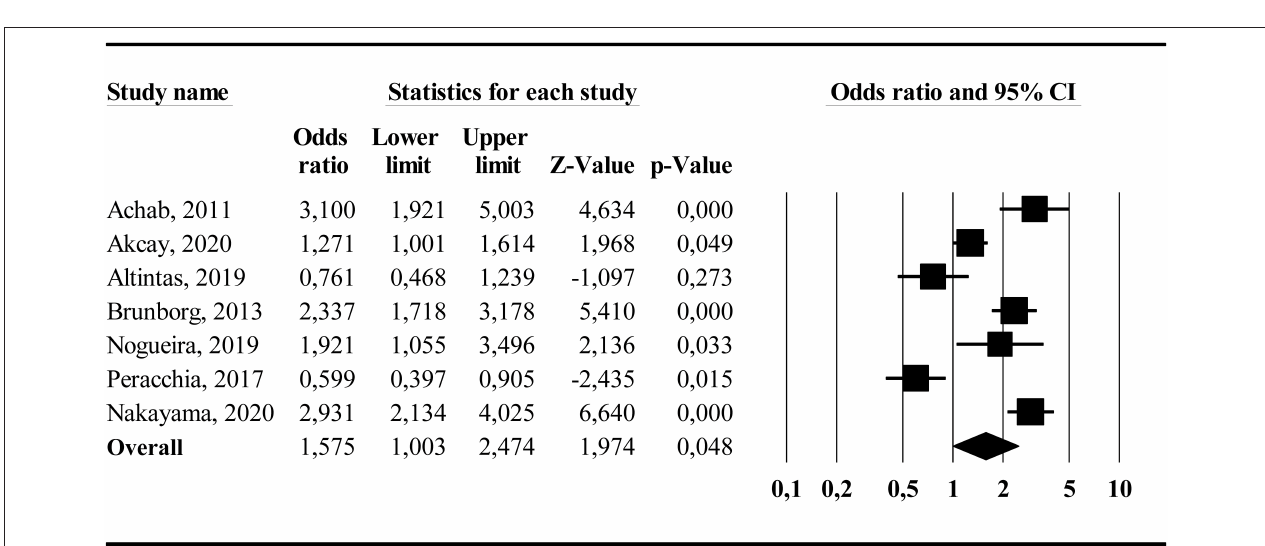
FIGURE 4 | Forest plot showing the association (odds ratio) between problematic gaming and daytime sleepiness.